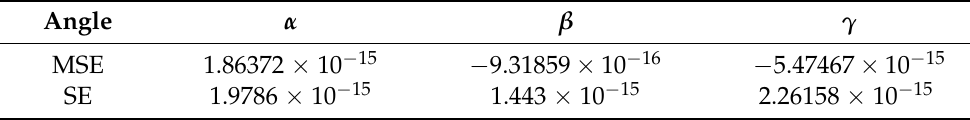
Table 8. Mean Squared Error (MSE) and Standard Error (SE) of the Orientation.